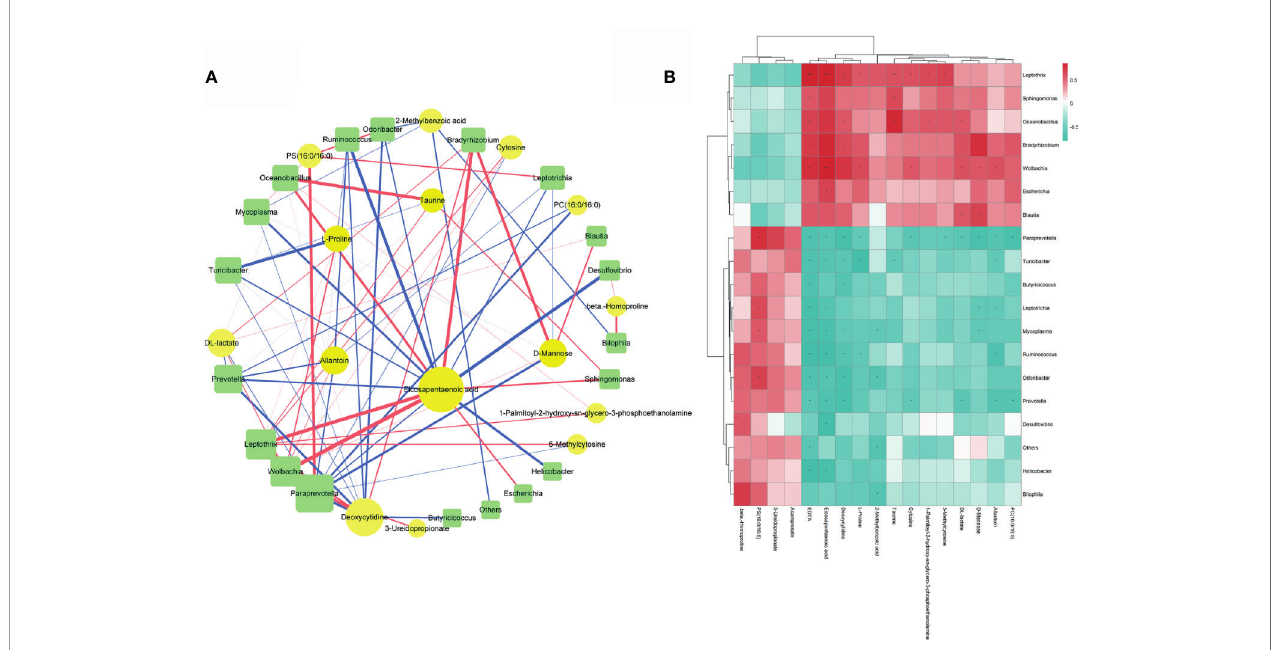
FIGURE 8 | (A) Spearman Correlation network among the differentially expressed fecal microbiota and plasma metabolites; circles represent metabolites and squares represent microbiota. Different line colors represent positive (red) and negative (blue) correlation coef fi cients, and the line width is proportional to the absolute value of the correlation coef fi cient. (B) Hierarchical clustering heatmap of differentially expressed fecal microbiota and plasma metabolites.